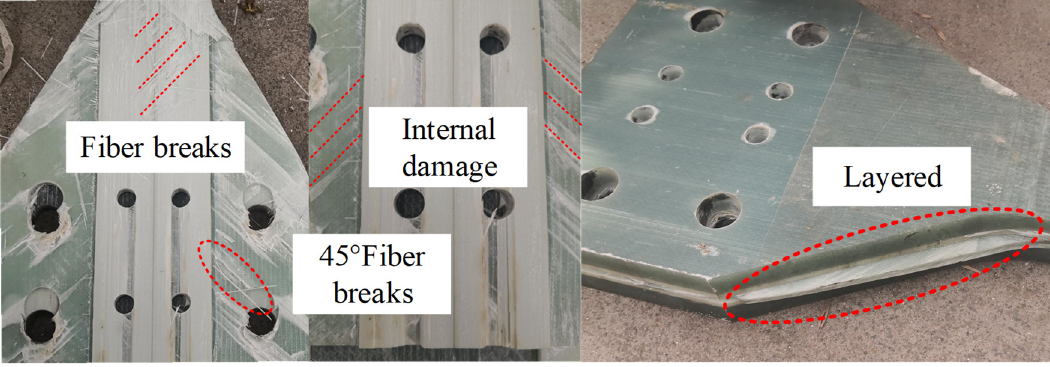
Figure 13. Failure area of pultruded sheet.